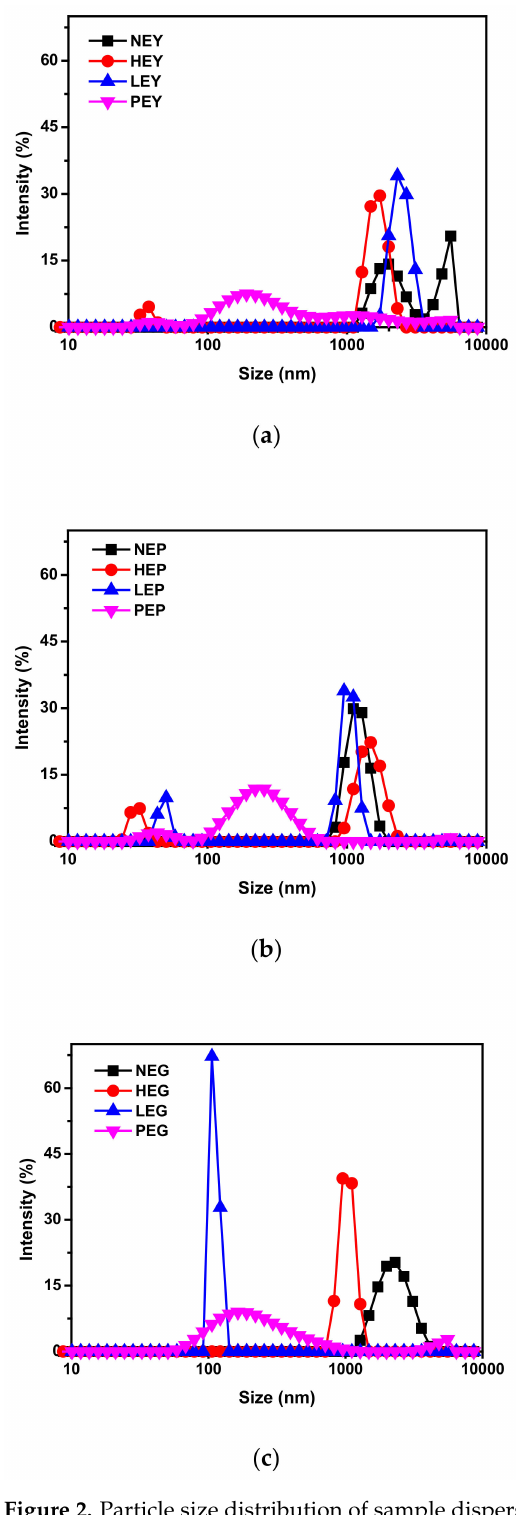
Figure 2. Particle size distribution of sample dispersions under different treatments. ( a ) NEY, HEY, LEY and PEY (natural egg yolk, heated egg yolk, egg yolk hydrolyzed by lipids and egg yolk hydrolyzed by phospholipase, respectively). ( b ) NEP, HEP, LEP and PEP (natural egg yolk plasma, heated egg yolk plasma, egg yolk plasma hydrolyzed by lipids and egg yolk plasma hydrolyzed by phospholipase, respectively). ( c ) NEG, HEG, LEG and PEG (natural egg yolk granule, heated egg yolk granule, egg yolk granule hydrolyzed by lipids and egg yolk granule hydrolyzed by phospholipase,